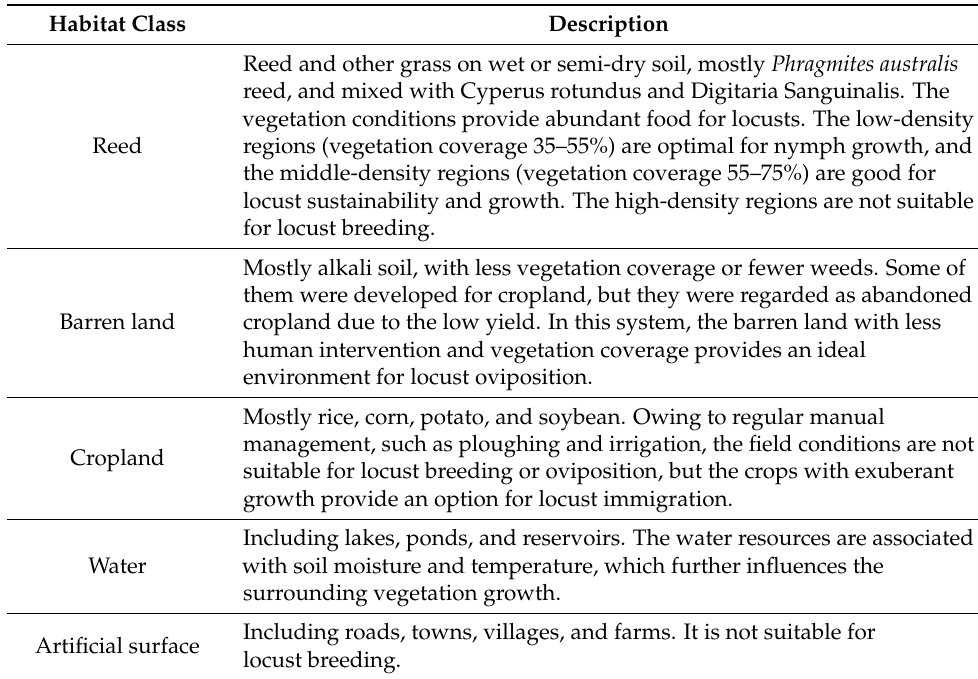
Table 1. Habitat classification system of AML.